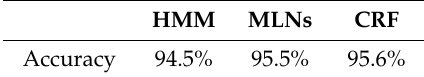
Table 3. The performance of our MLNs-based method, HMM and